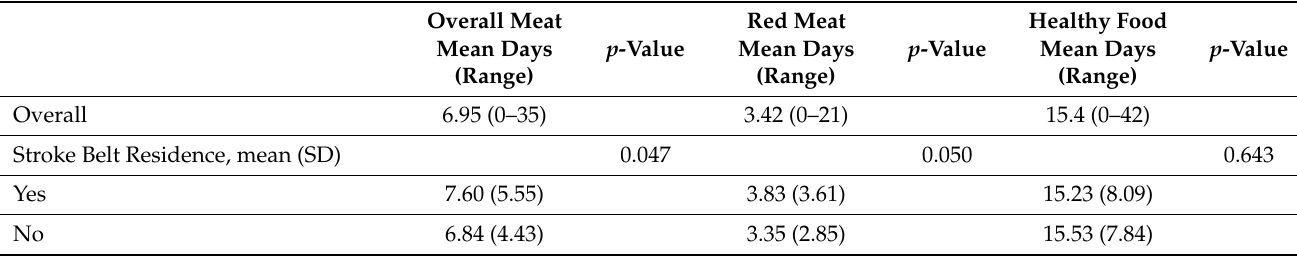
Table 2. Dietary habits of